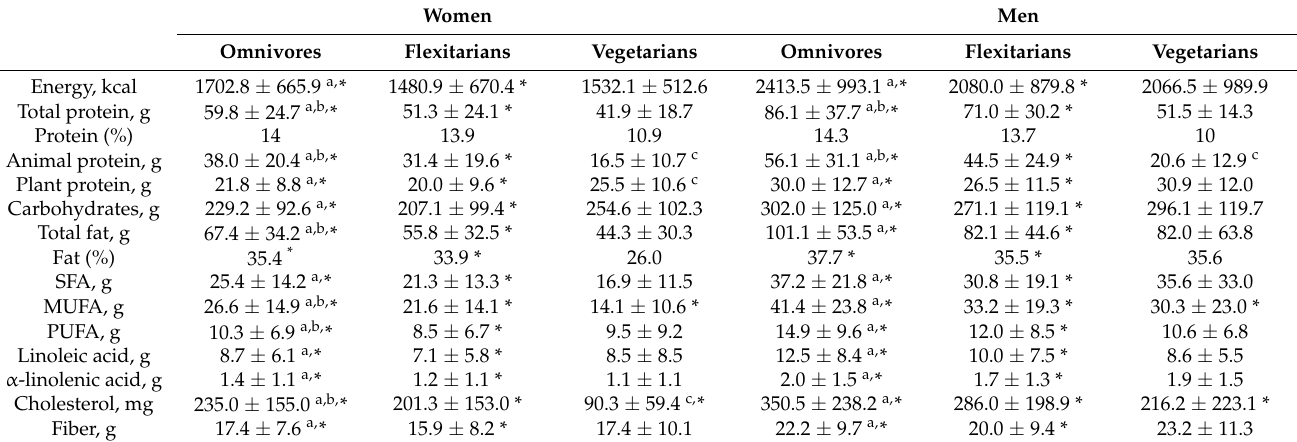
Table 2. Daily intake of energy, macronutrients, cholesterol and fiber among the study participants.